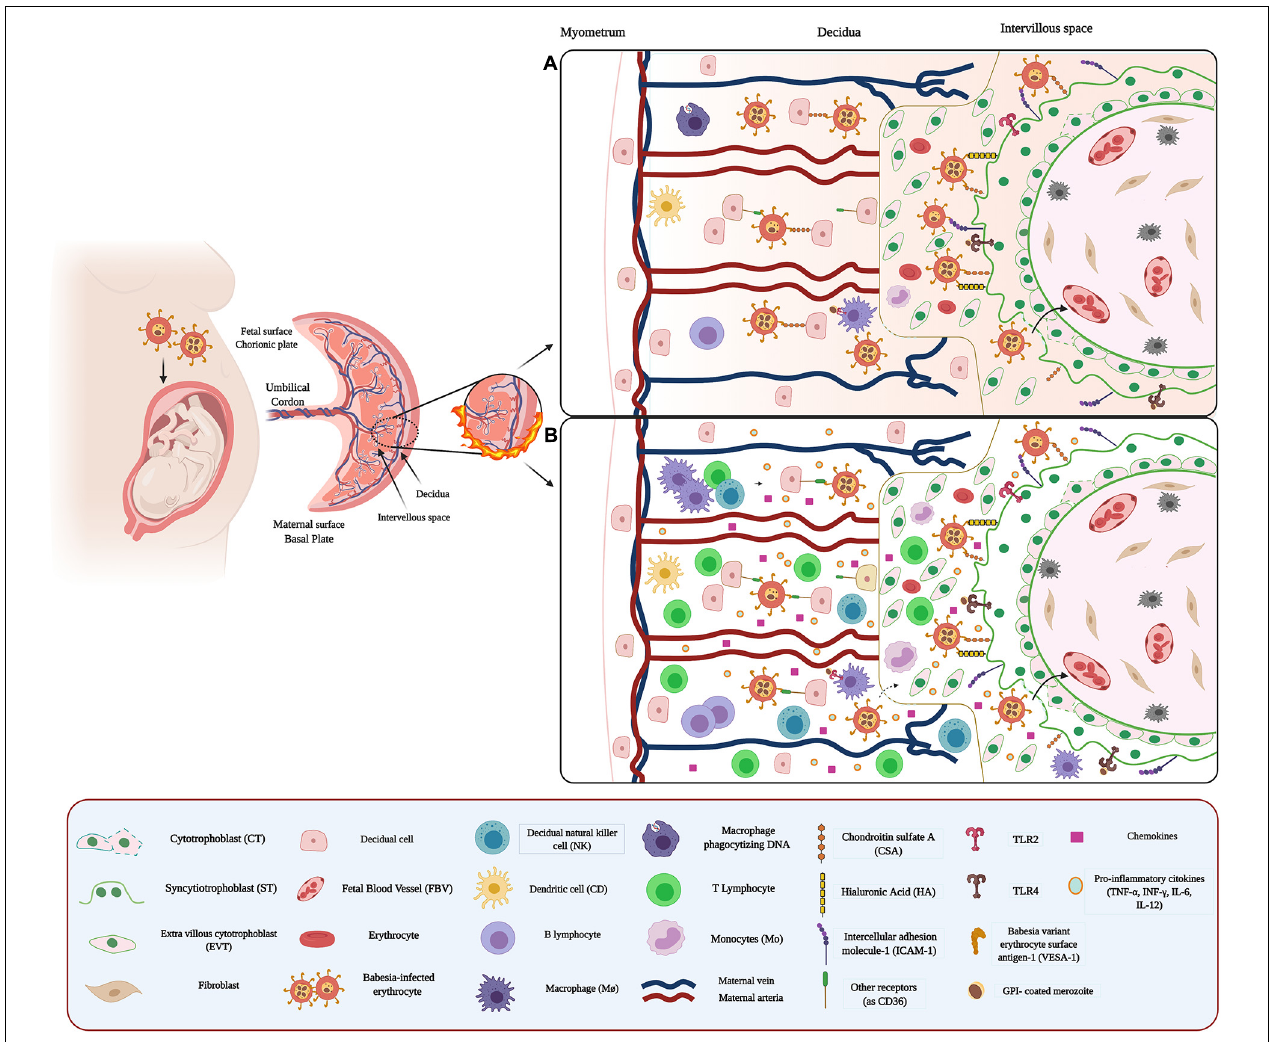
FIGURE 2 | Host–pathogen interaction between Babesia and placenta: (A) Adhesion and sequestration of Babesia -IEs Infection of erythrocytes by the parasite induces expression of parasite-derived proteins on the surface of the IEs. Babesia-infected IEs highly express the VESA1 family and possibly act as a surface antigen and ligand for adhesion and sequestration of IEs in the placenta. VESA1 selectively binds to specific placental receptors, such as CSA, HA, and ICAM-1, expressed by ST, participate as key molecules in this adhesion process. In addition, some receptors such as CD36 could also facilitate the adhesion of IEs in other regions of the placenta, such as the decidua. (B) Microenvironment and inflammatory response against Babesia . Inflammation in the IVS and decidua could be attributed to chemokines and cytokines secreted by maternal M (cid:56) , Mo, B cell, and T cells, as well as